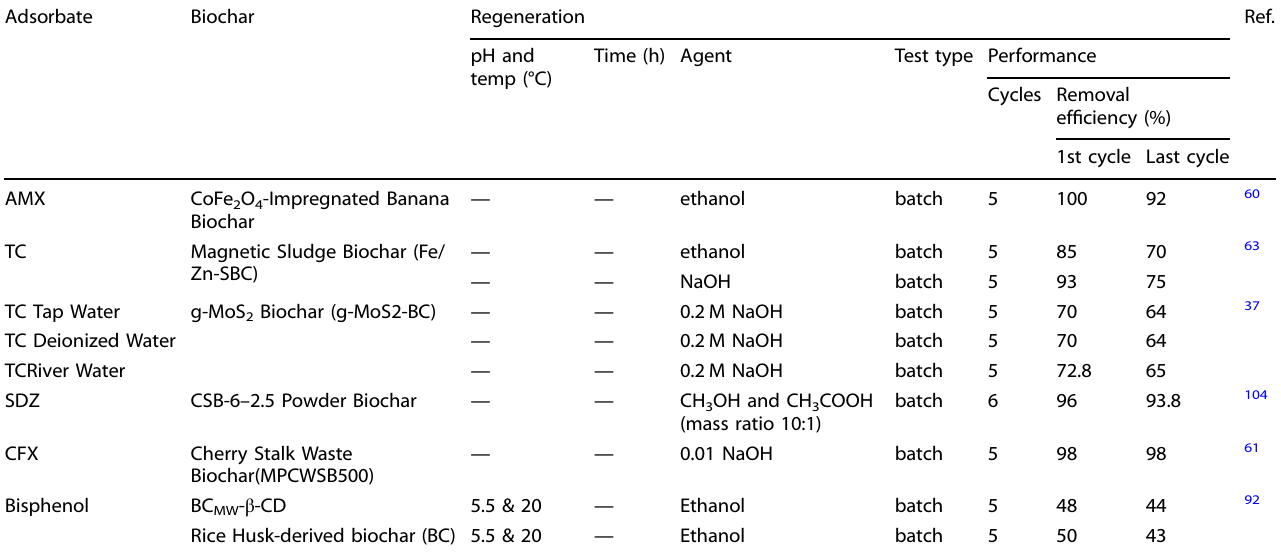
Table 11. Reusability of biochar after adsorbing antibiotics from wastewater through the chemical regeneration process.